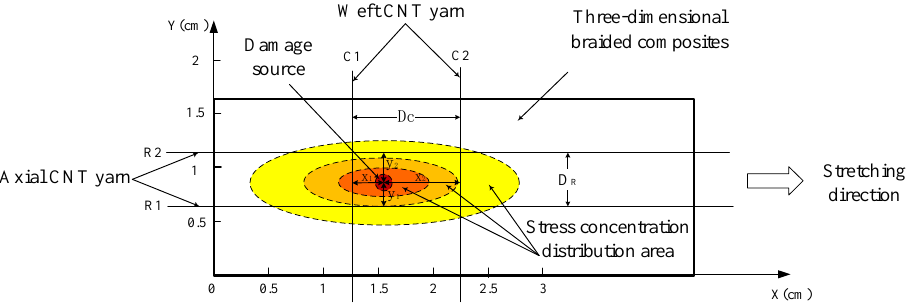
Figure 5. Schematic diagram of CNT yarn sensor damage location.